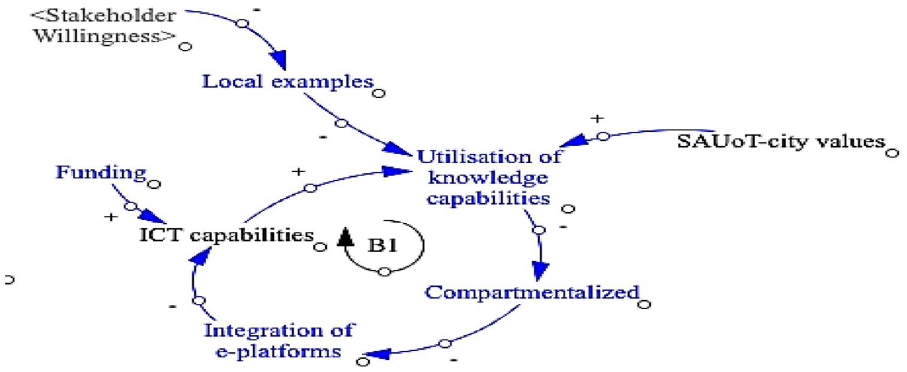
Figure 7. Reinforcing loop